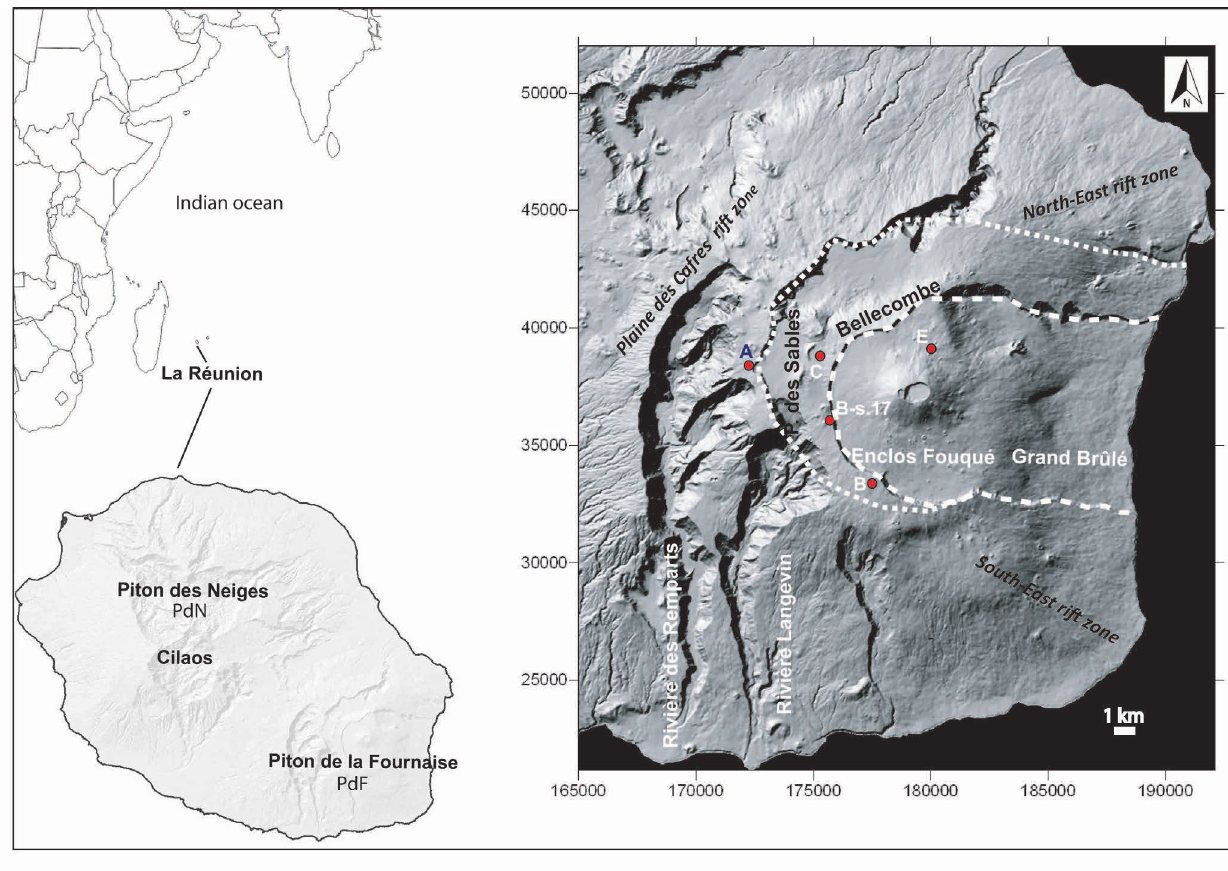
Figure 1: Map of La Réunion island (France) showing the sampling sites (red dots) on PdN and PdF volcanoes. Out- lines of Plaine des Sables and Bellecombe calderas and flank collapses are schematically redrawn from Michon et al.